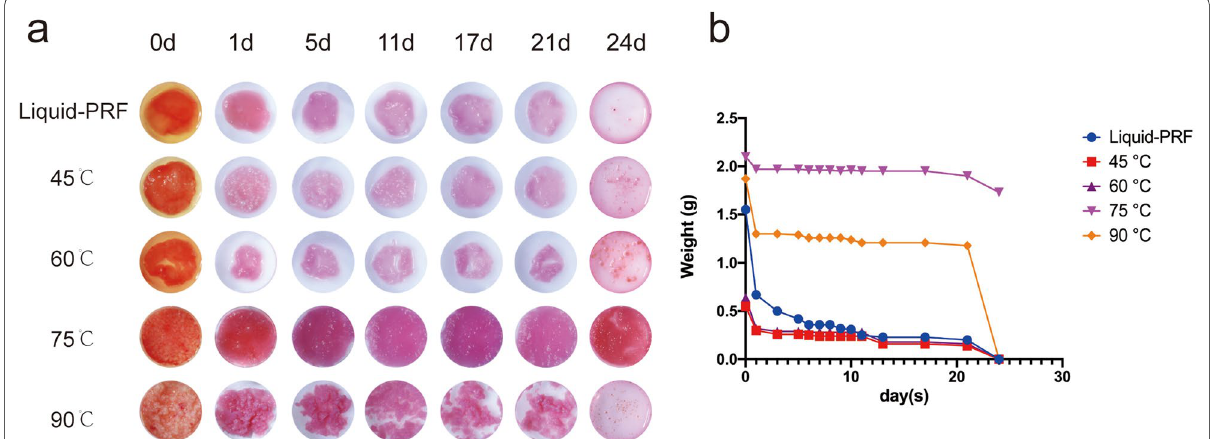
Fig. 3 Degradation of H-PRF gels